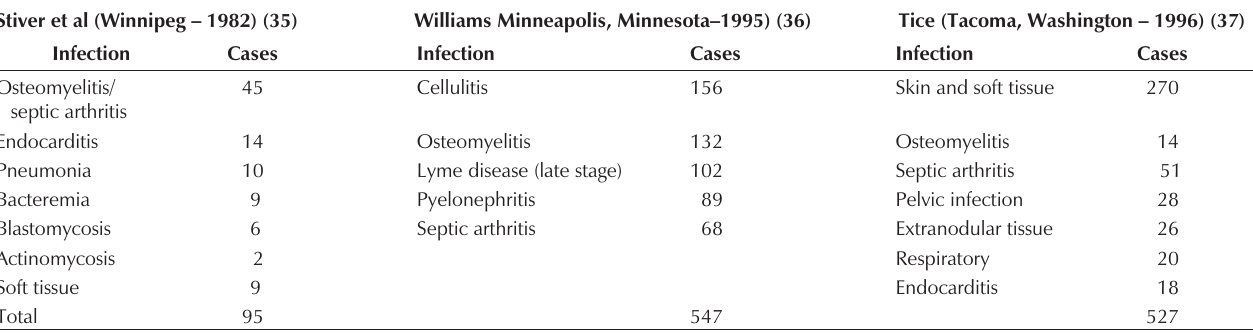
Infections treated with outpatient parenteral antibiotic